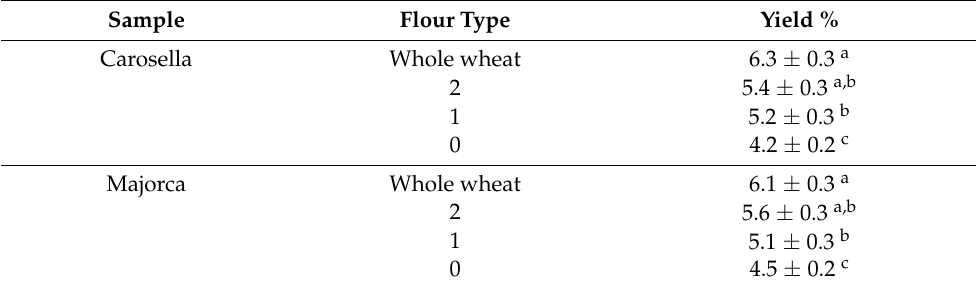
Table 1. Yield percentage of methanolic extracts obtained from Carosella and Majorca samples (% dry matter).